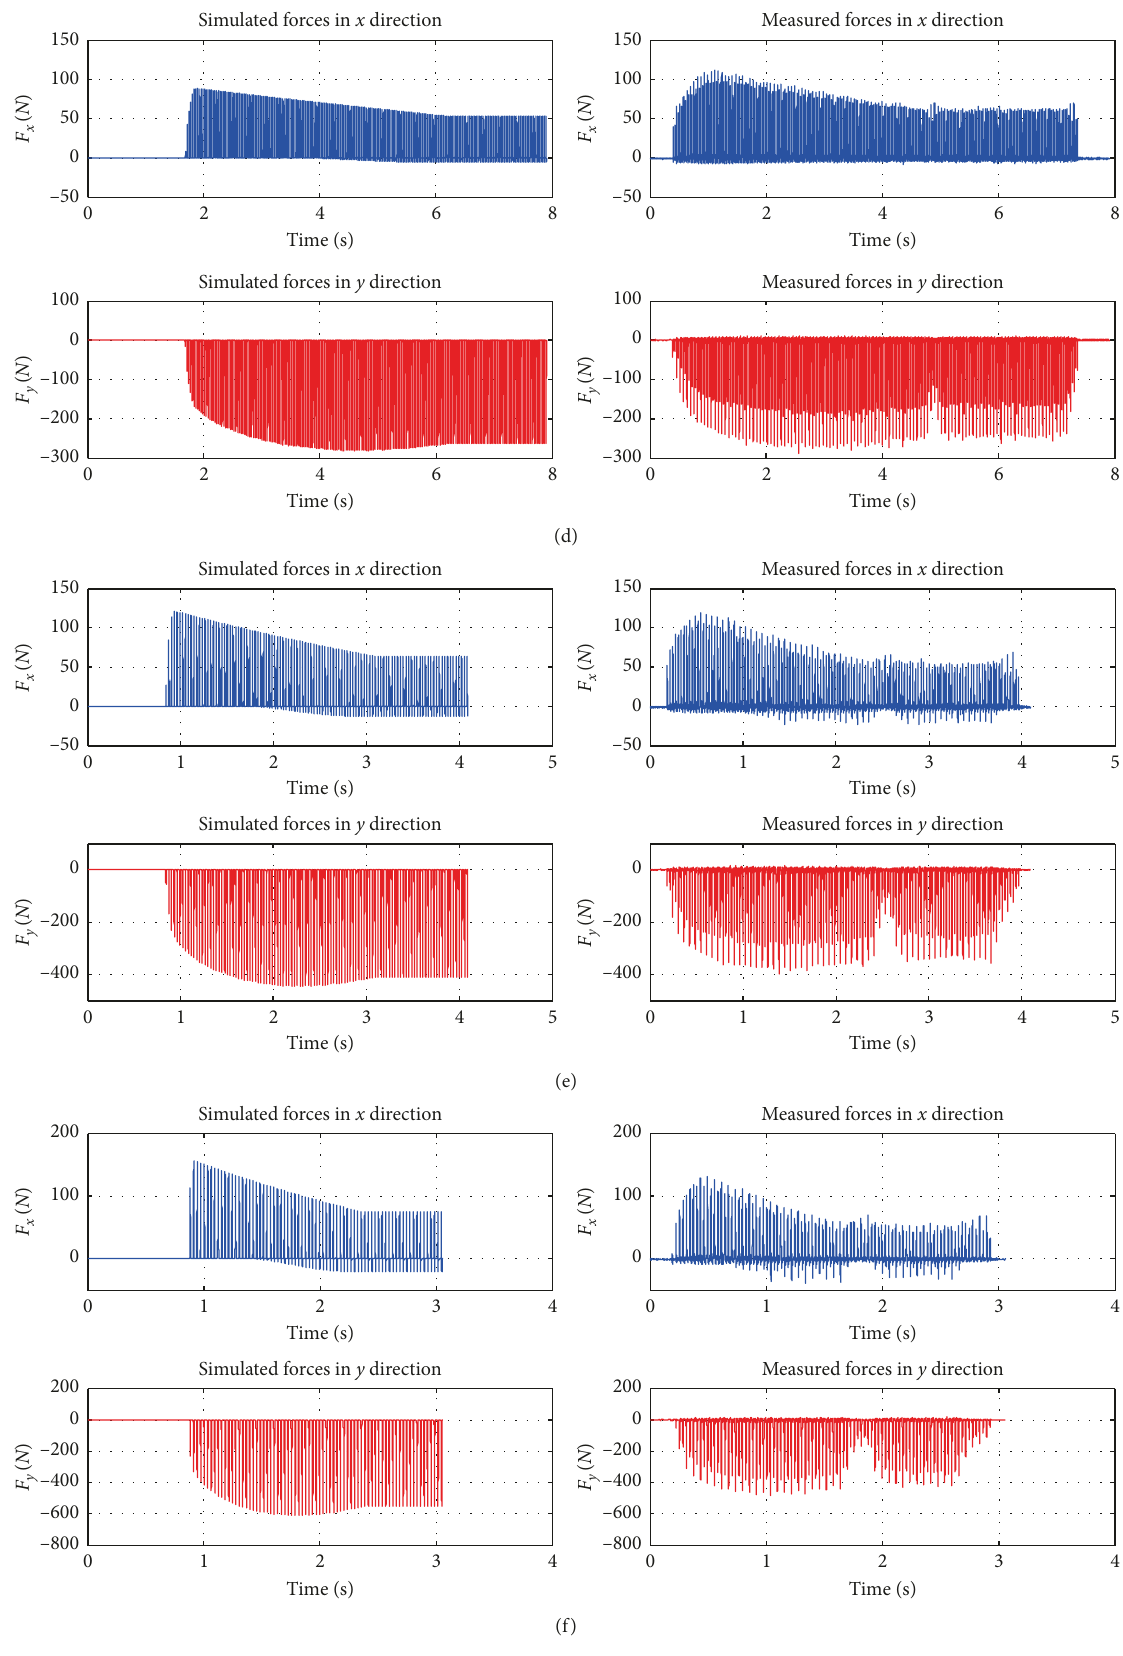
Figure 17: Predicted and measured forces while the cutter entering the workpiece along the cycle path: (a) Test No.1, (b) Test No. 2, (c) Test No. 3, (d) Test No. 4, (e) Test No. 5, and (f) Test No.